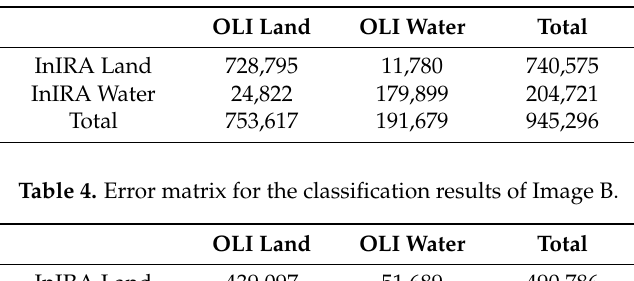
Figure 3. Radar backscattering coefficients changes with surface roughness for incidence angle ( A ) 2 ◦ ; ( B ) 5 ◦ and ( C ) 8 ◦ . VSM, volumetric soil moisture.